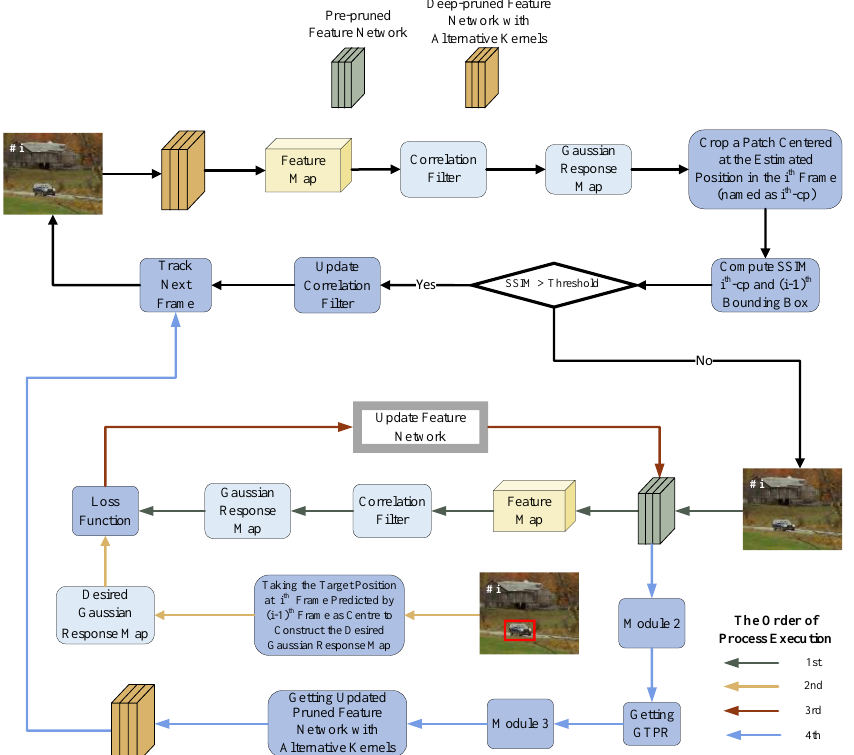
Figure 6. Correlation filter tracking model based on the deep-pruned feature network and online updating process of the deep-pruned feature network (including alternative kernels). ( #𝑖 indicates the 𝑖 𝑡ℎ picture in the video sequence)